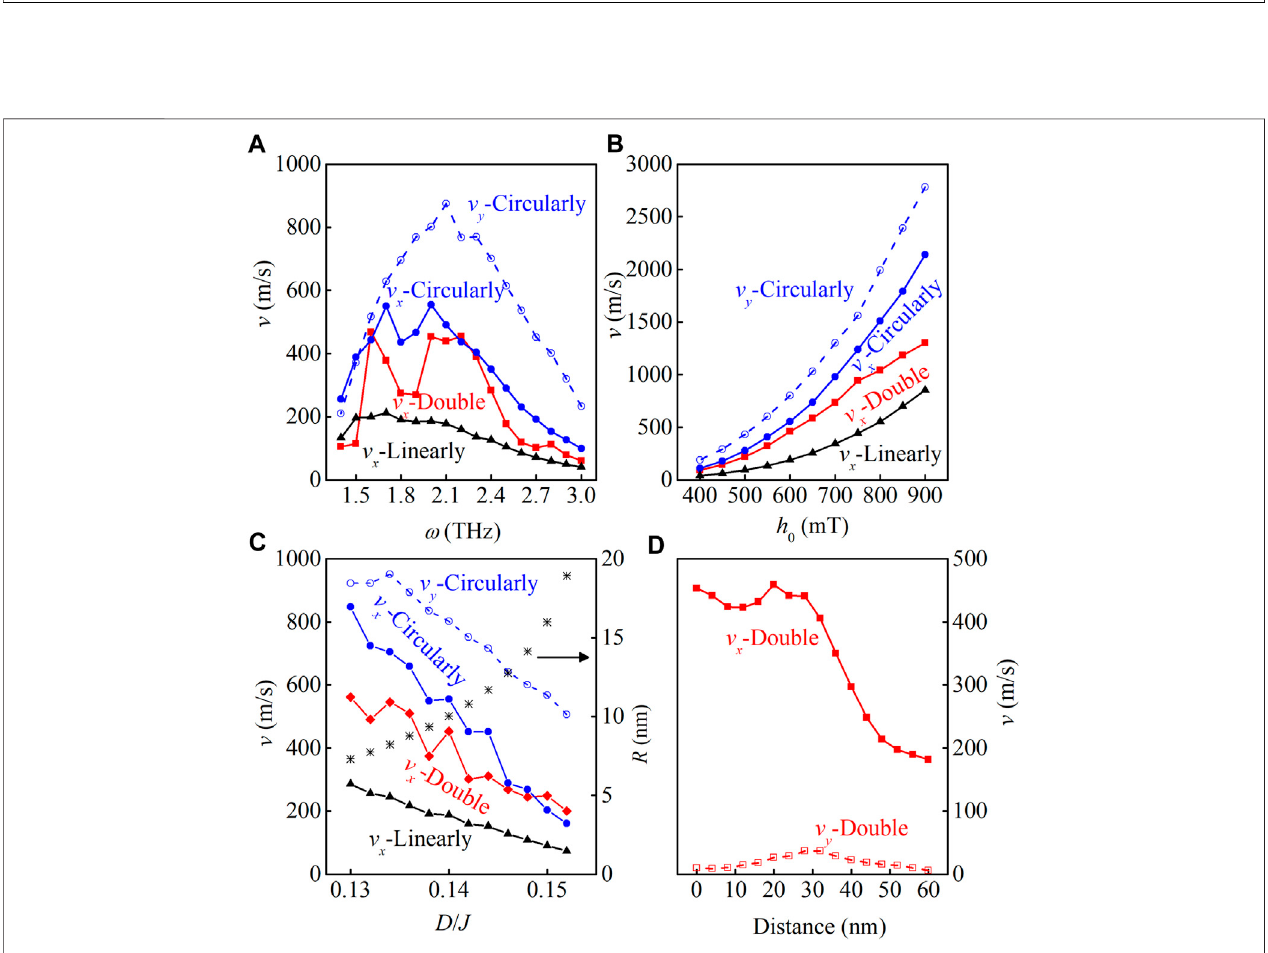
FIGURE4| Thesimulatedspeeds oftheskyrmion driven bythedoublecircularlypolarizedspinwaves v x -Double, bythe y linearlypolarized spin waves v x -Linearly, by the right-handed polarized spin waves v x -Circularly and v y -Circularly as functions of (A) ω for h 0 (cid:1) 600mT, (B) h 0 for ω (cid:1) 2 THz, and (C) D for h 0 (cid:1) 600 mT and ω (cid:1) 2 THz. (D) The simulated v x and v y asfunction ofthe distance between the two spin wave sources for h 0 (cid:1) 600 mT and ω (cid:1) 2 THz. The simulated skyrmion radii are also presented in (C) .